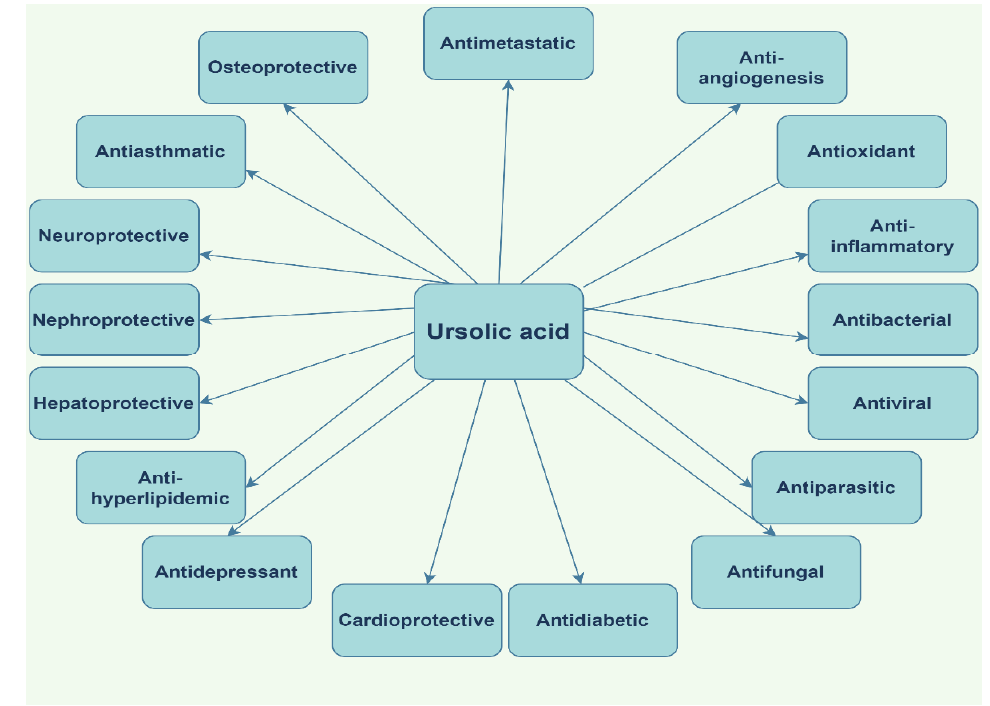
Figure 13. Biological activities of ursolic